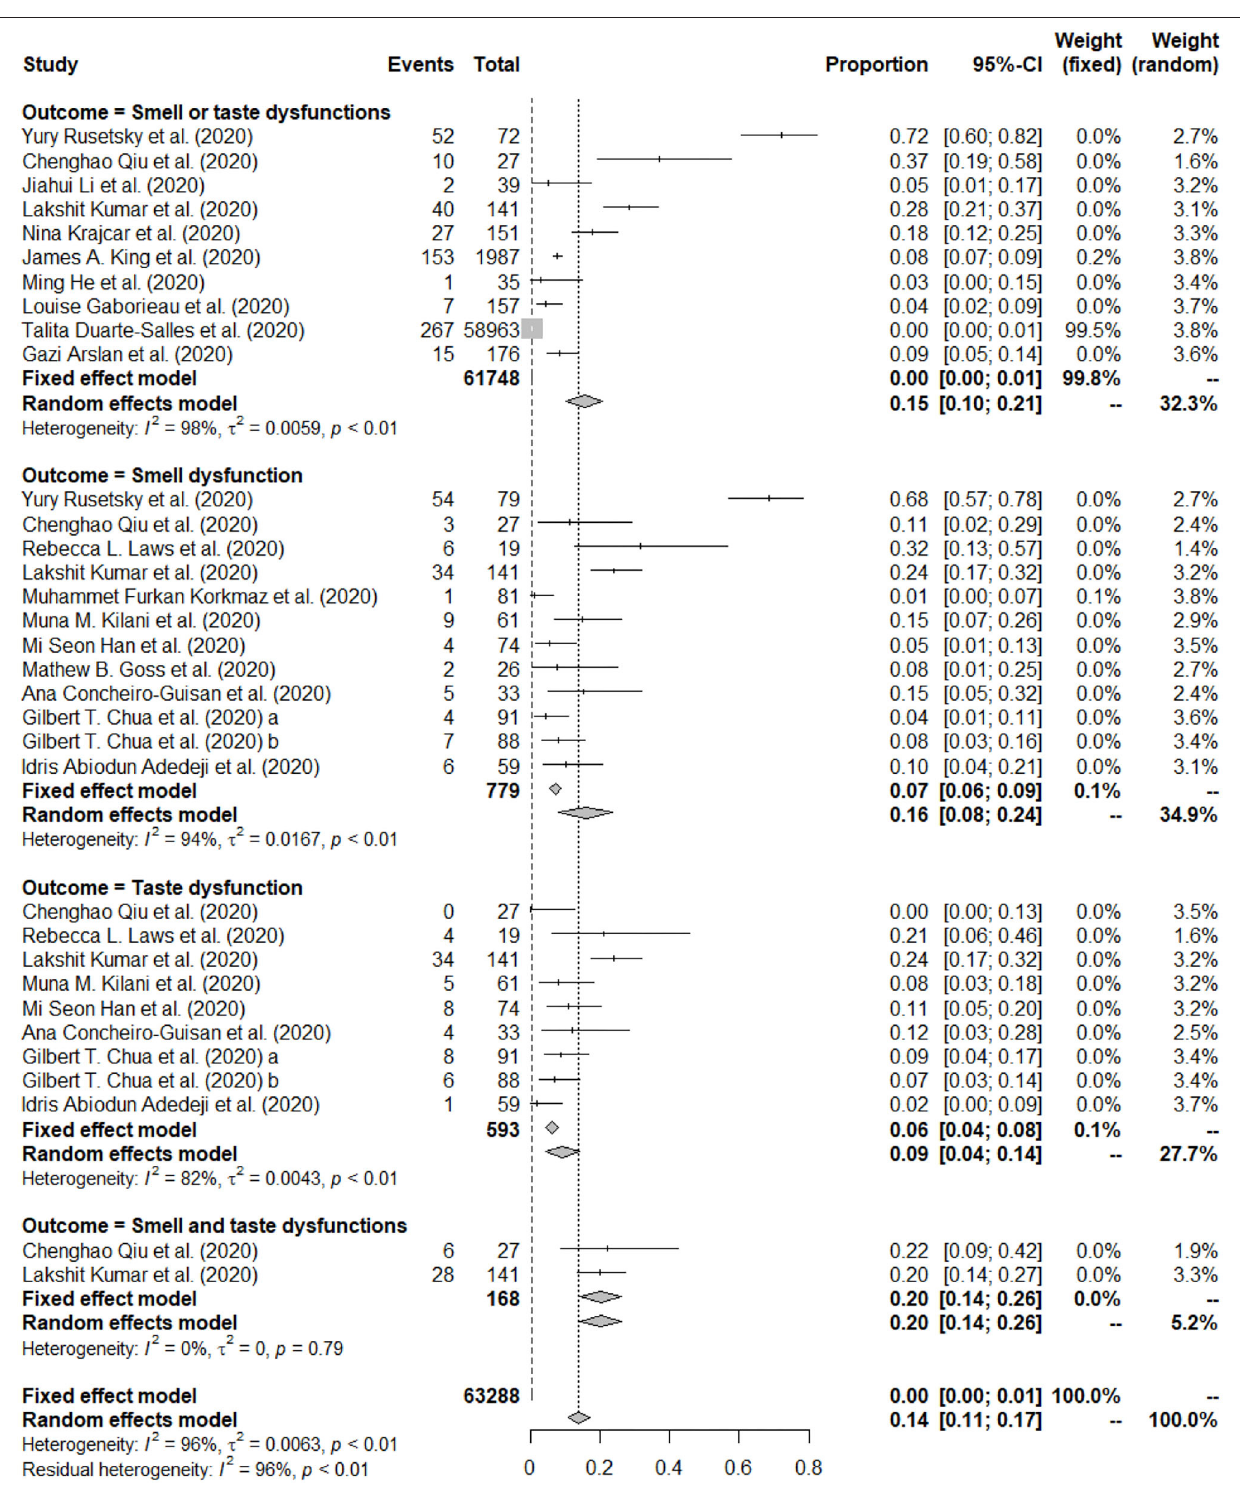
FIGURE 2 | Forest plot of pooled prevalence of smell or/and taste dysfunction.